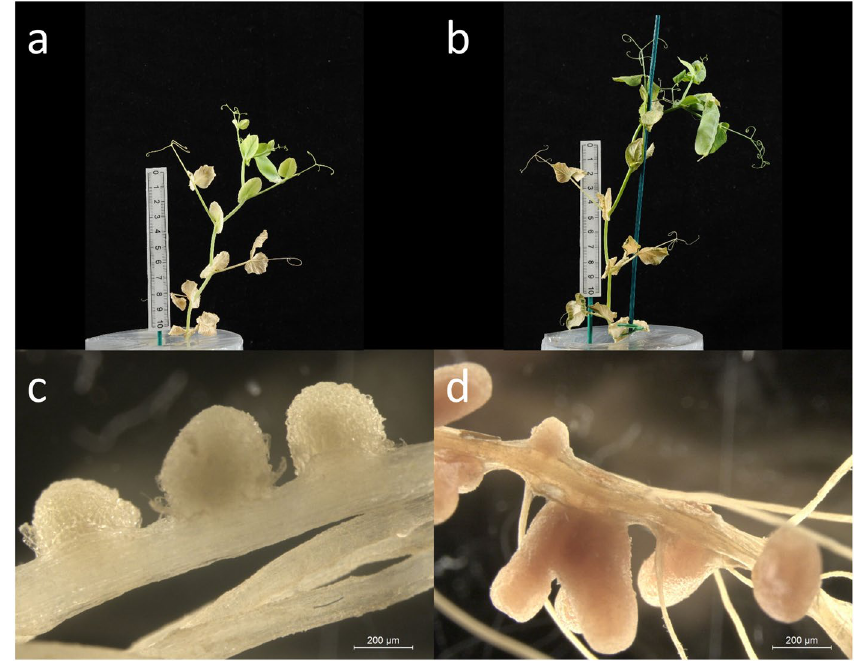
Figure 1. Comparison of the non-fixing strain RU3940, ( a , c ) and the otherwise isogenic fixing strain Rlv3841 ( b , d ). After five weeks of growth, plants inoculated with the non-fixing strain ( a ) had reduced biomass and produced fewer peas than those inoculated with the fixing strain ( b ). The non-fixing strain formed white ( c ), rather than pink ( d ), nodules, indicating a lack of leghaemoglobin. Scale bars indicate 200 μ